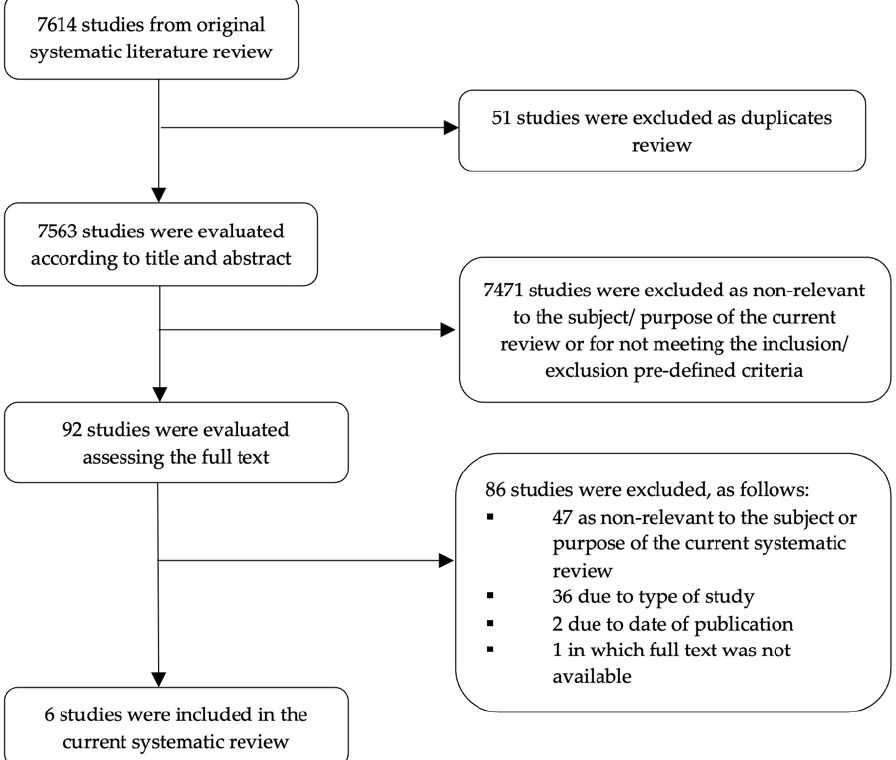
Figure 1. Flow chart of the stepwise study selection process.